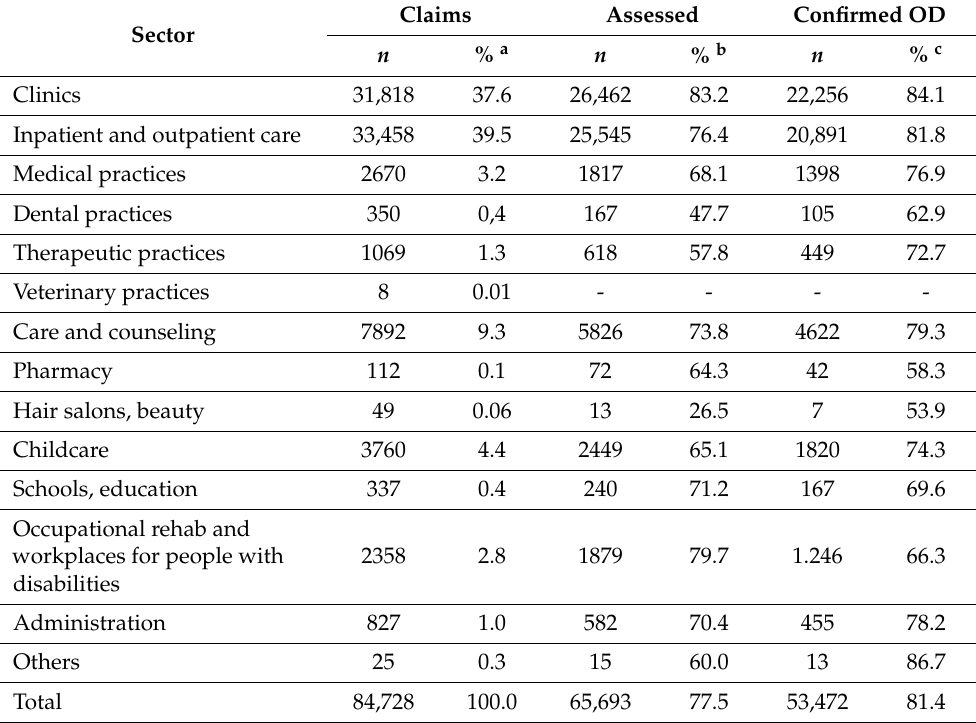
Table 1. COVID-19 cases reported to accident insurance provider BGW and confirmed occupational disease (OD) by